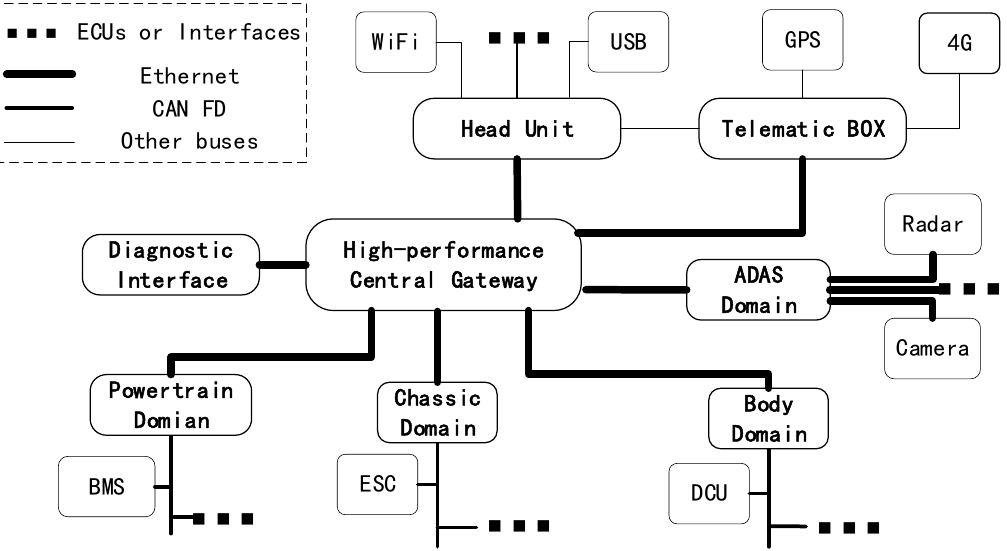
Figure 1. Future trends of in-vehicle electronic and electrical (E/E) architecture.